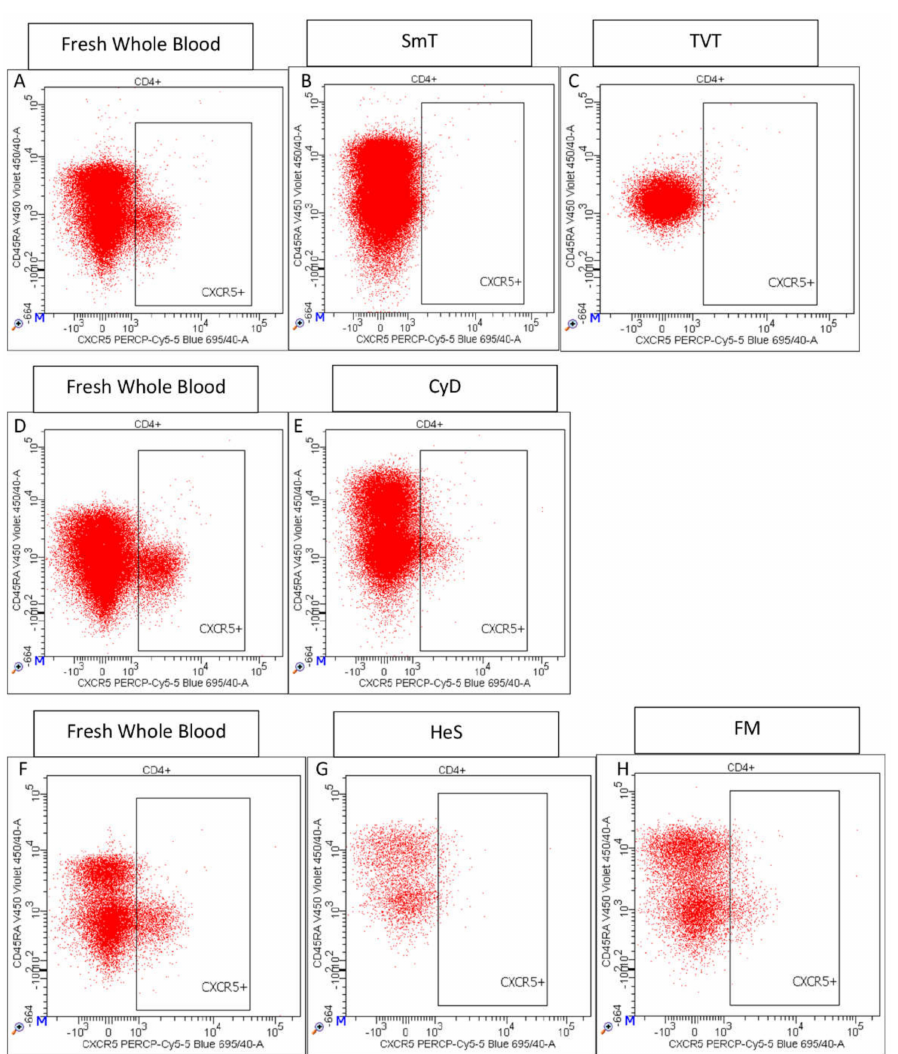
Figure 7. Representative CXCR5 staining of fresh whole blood and thawed samples. The correspond- ing fresh whole blood is shown on the same line for each freezing method: fresh blood ( A ) is the control for SmT ( B ), and TVT ( C ) methods; fresh sample ( D ) is used as the control for CyD ( E ) method, and fresh sample ( F ) for HeS ( G ) and FM ( H )